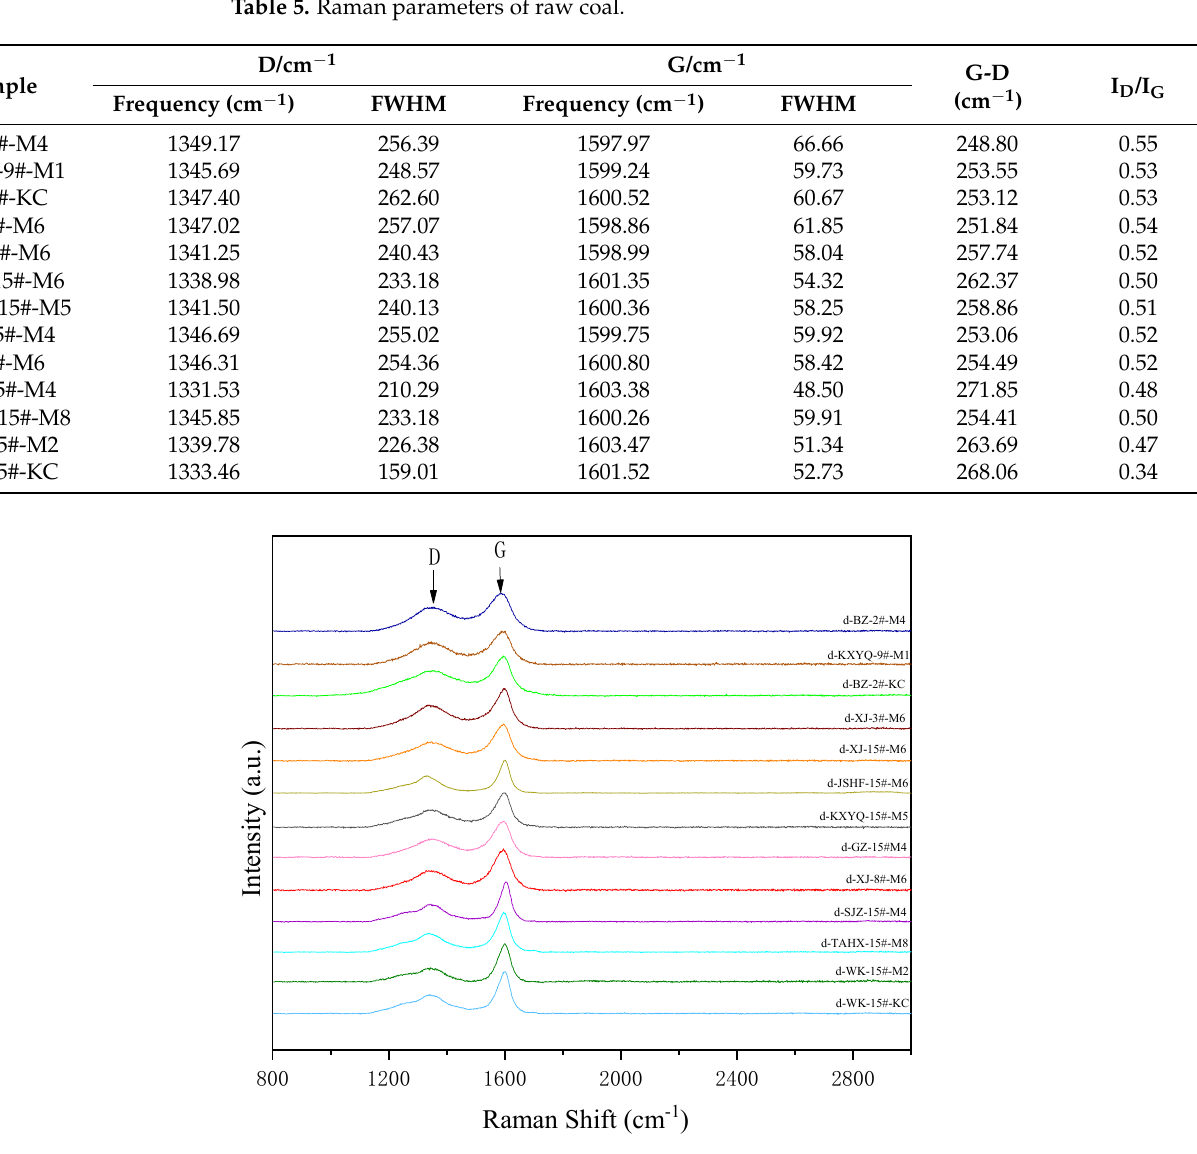
Figure 8. Raman patterns of demineralized coal. Table 6. Raman parameters of demineralized coal.